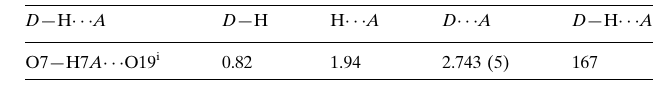
Hydrogen-bond geometry (A˚ , (cid:2)